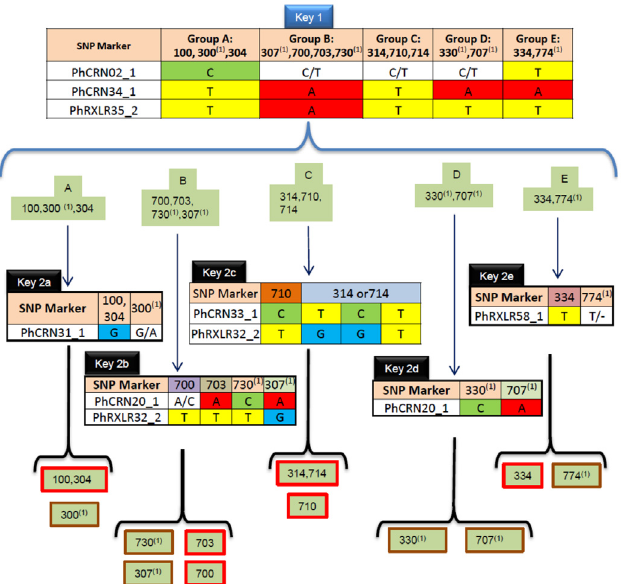
Fig 4. Identification key for Pl . halstedii pathotypes using KASP markers designed on effector gene SNPs. First level (Key 1) separated the 14 Pl . halstedii pathotypes in 5 groups with 3 markers. Second level (Key 2) used five other markers to distinguish 12 subgroups of pathotypes, and especially 6 subgroups of multi-isolate pathotypes (Red boxes). 100 and 304, 314 and 714 pathotypes could not be distinguished. 1 Pl . halstedii pathotypes with only one isolate